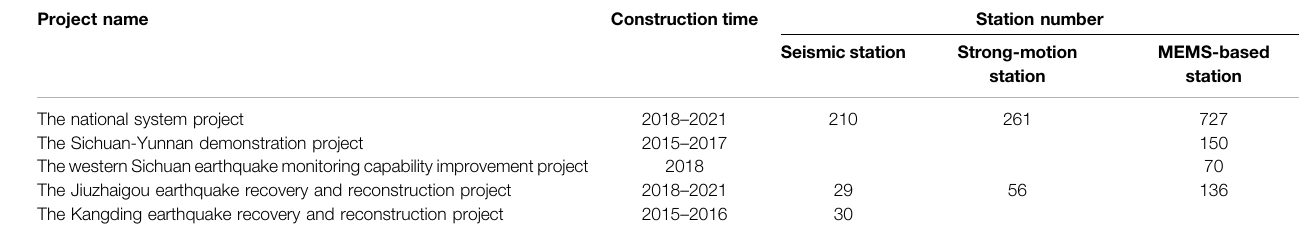
TABLE 2 | Number of stations under construction in different projects.